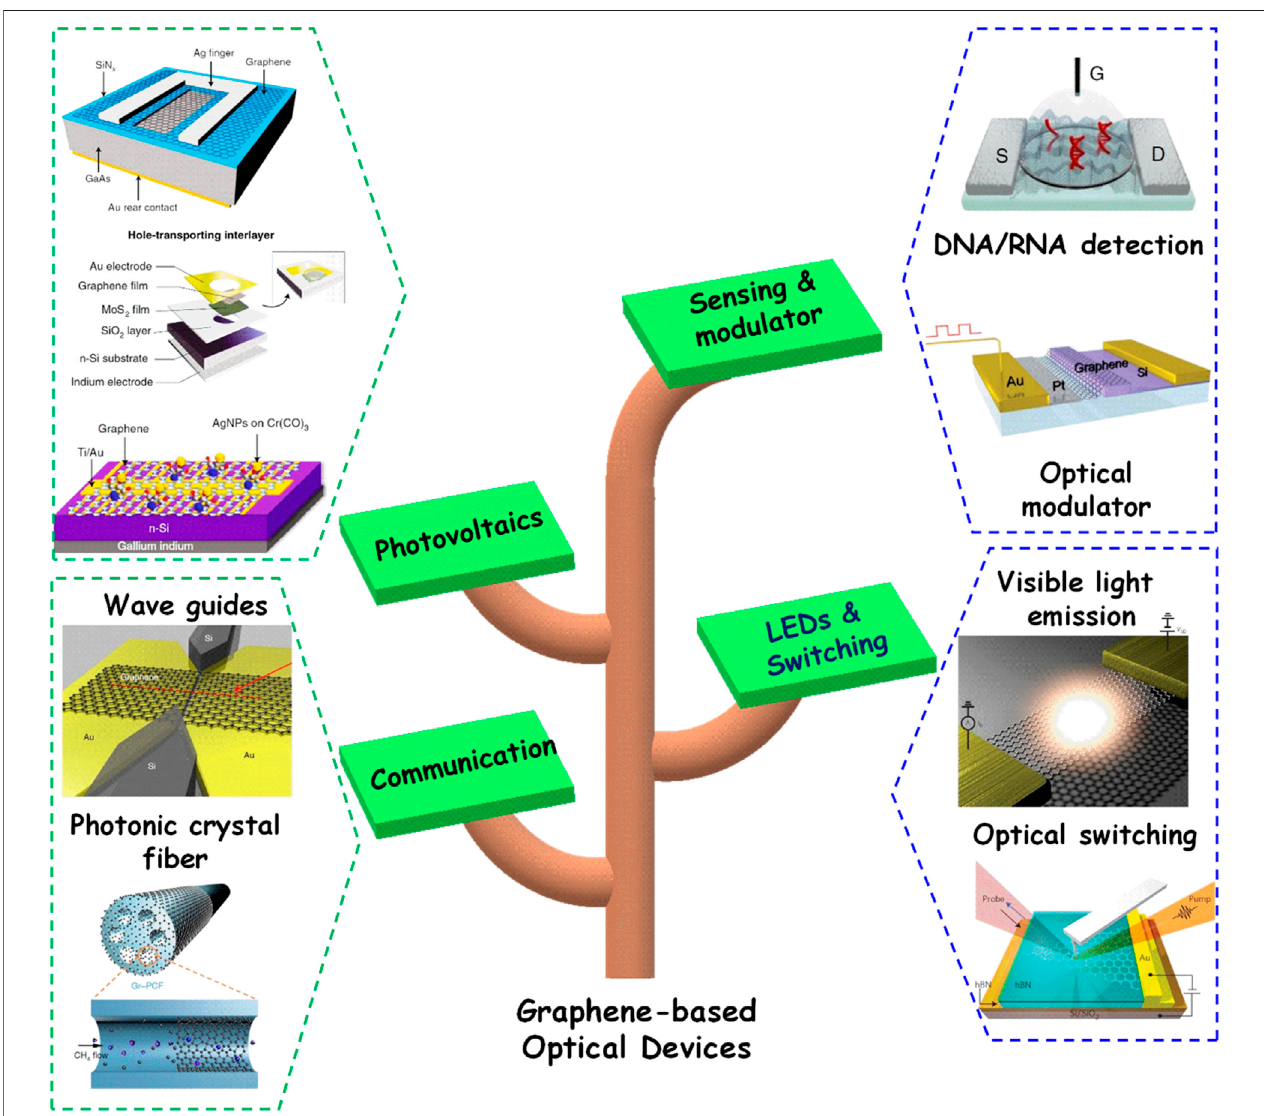
FIGURE 2 | Schematic representation of graphene-based optical device applications [adapted and modi fi ed from (Kim et al., 2015; Ni et al., 2016; Chen et al., 2019; Behura et al., 2019; Ono et al., 2020; Hwang et al., 2020)].